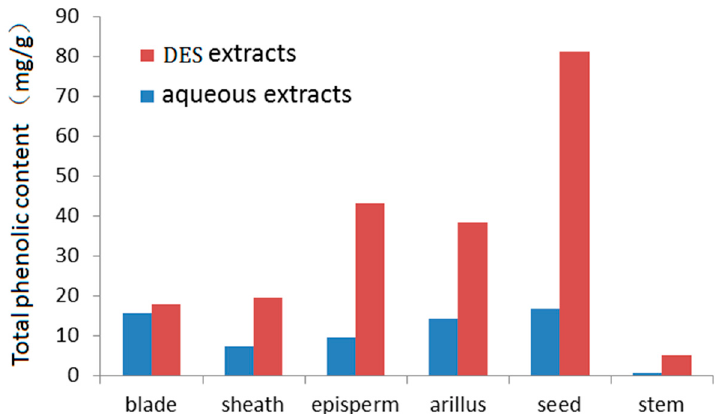
Figure 8. Contents of total phenolic in rattan plant.